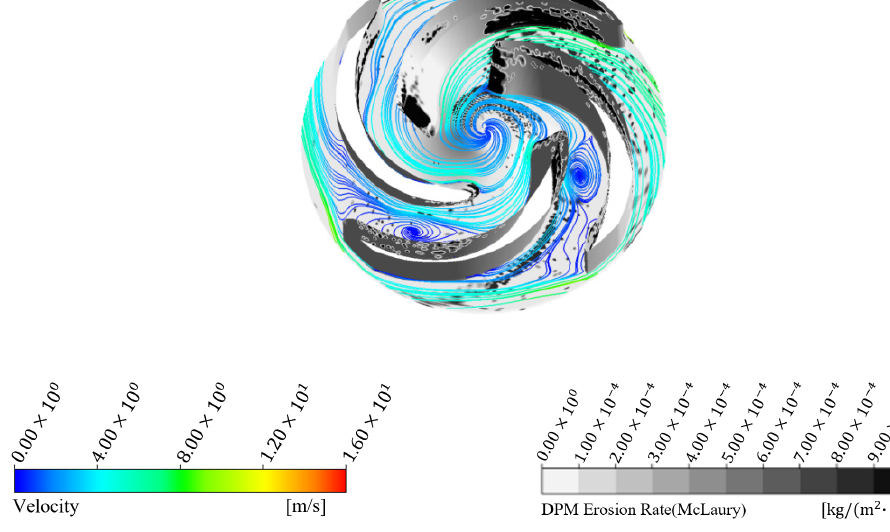
Figure 13. Velocity streamlines and wear in the impeller.